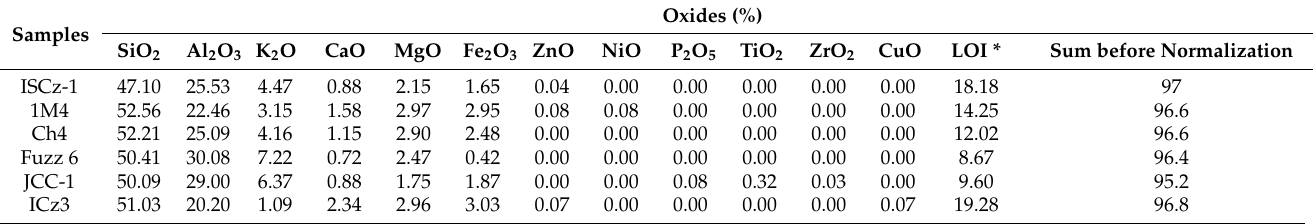
Figure 2. XRD patterns of sample JCC-1 before and after purification. Q-Quartz. Table 3. Chemical compositions of samples obtained by XRF analysis (<0.2 µ m).